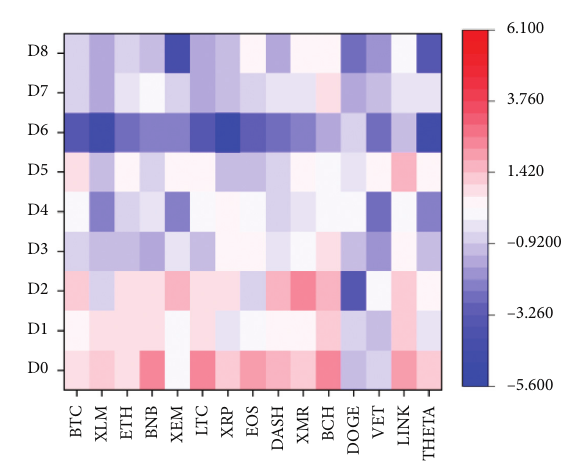
Figure 8: Causality test under D7.